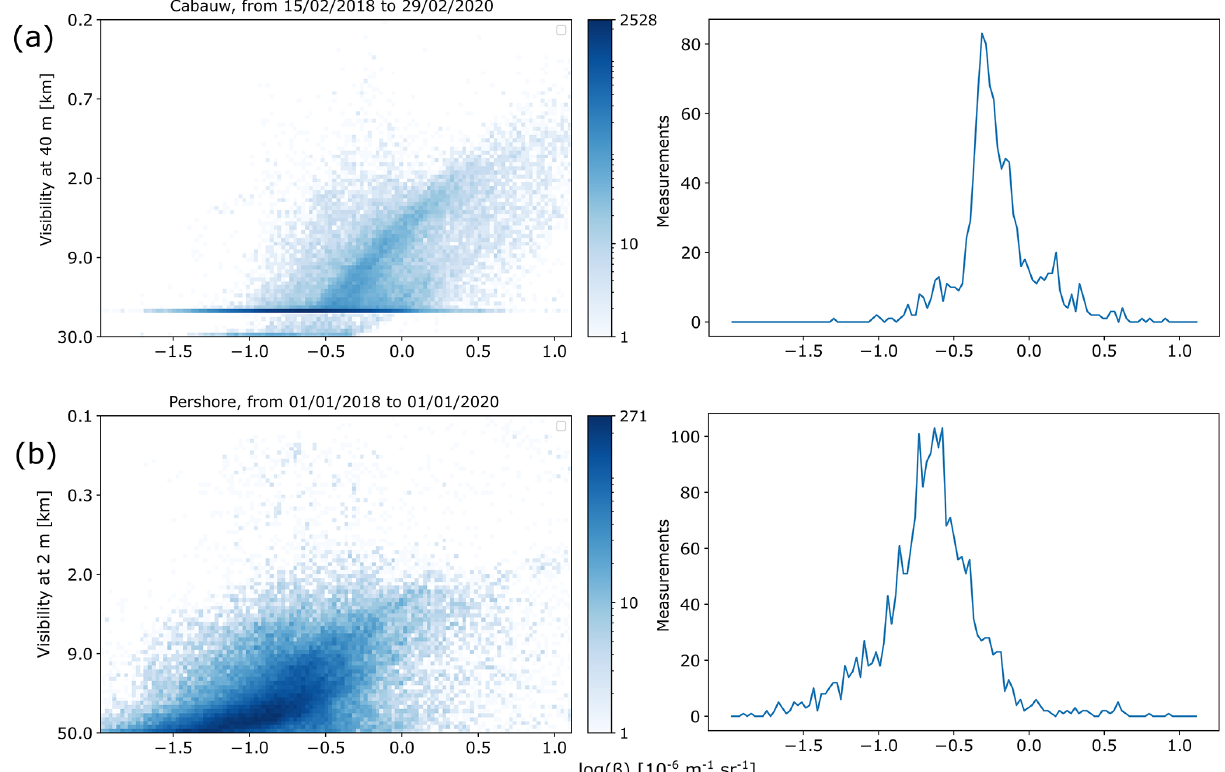
Figure 3. Overview 2D histogram scatter plots of inverse visibility versus backscatter (both logarithmic). For better readability, y -tick labels of visibility are shown. The backscatter is logarithmic to facilitate display due to its large dynamic range. (a) Scatter plot for Cabauw, with backscatter distribution at 12km visibility, indicating a peak at 10 − 0 . 3 × 10 − 6 m − 1 sr − 1 . Visibility measured at 40ma.g.l. and backscatter from 39ma.g.l. (b) Scatter plot for Pershore, with backscatter distribution at 12km visibility. Visibility measured at 2ma.g.l. and backscatter from